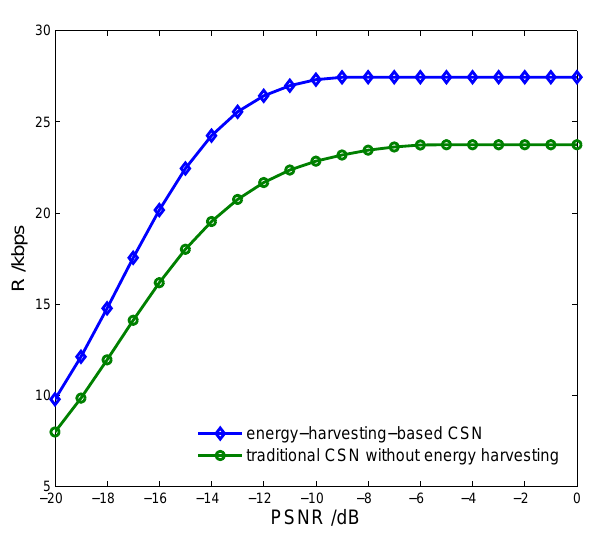
Figure 15. Transmission rate vs. cognitive sensor network model with PU signal to noise ratio.